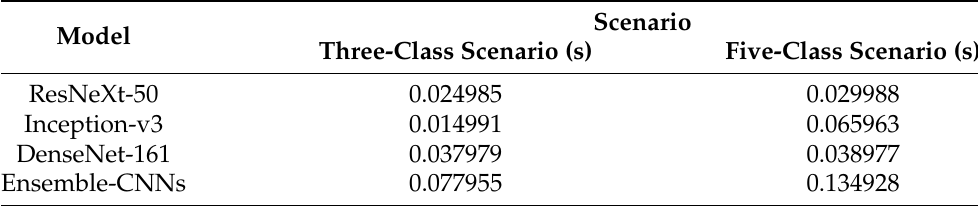
Table 14. Testing time for the evaluated CNN architecture and our proposed Ensemble-CNNs approach for three-class and five-class